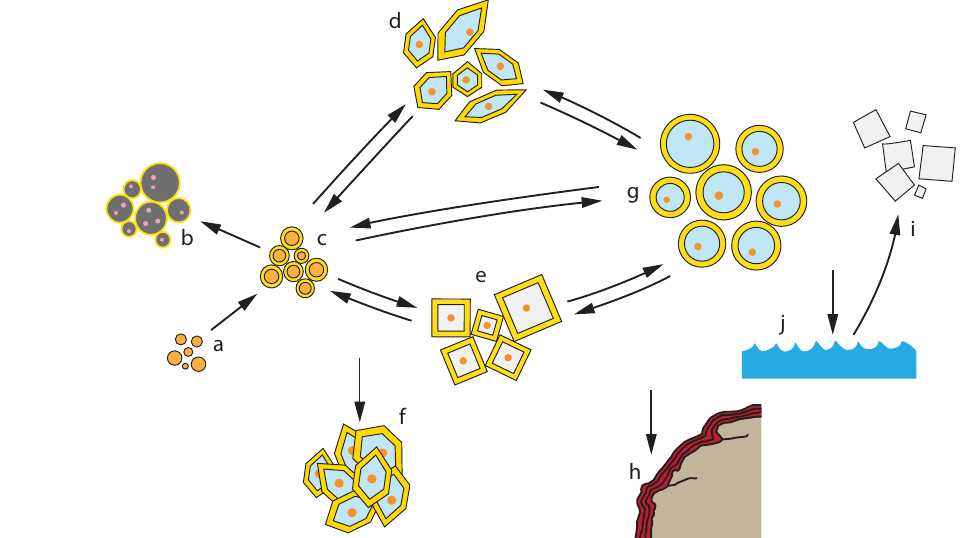
Figure 4. Schematic representation of iron salt aerosol interactions with different solid surfaces: primary ISA precursor FeOOH particles (a) react with gaseous HCl by generation of ISA as FeCl 3 coated on FeOOH particles (c). Coagulation, condensation and chemical reaction with particles and vapors produce different kinds of liquid and/or solid ISA variants and sediments: (b) hydrolyzed FeCl 3 coated on soot and/or HULIS particles; (d) hydrolyzed FeCl 3 coated on ice crystals; (e) hydrolyzed FeCl 3 coated on salt crystals; (f) hydrolyzed FeCl 3 coated on ice crystals of snow layers (ISA sediment); (g) hydrolyzed FeCl 3 dissolved in cloud droplets; (h) FeCl 3 hydrolysate residue on desert varnish (ISA sediment); (j) hydrolyzed FeCl 3 as dissolved residue in ocean surface water fertilizes the phytoplankton growth and ultimately triggers the generation of sulfuric, sulfonic and dicarboxylic acids by emission of DMS, MC and other organics. This activates the tropospheric generation of vaporous HCl by reaction of sea-salt aerosol (i) with the acids. HCl again changes the ISA precursor FeOOH aerosol (a) to ISA